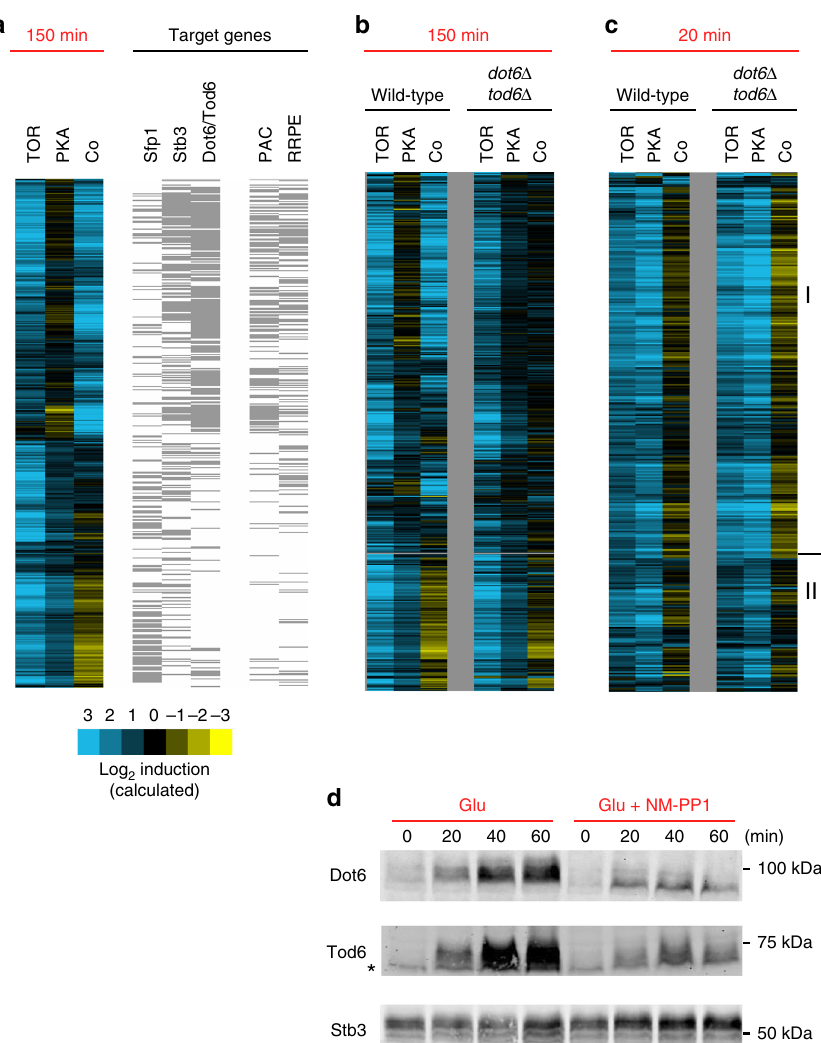
Fig. 4 The role of Dot6/Tod6 in TORC1 – PKA signaling. a Comparison of the TORC1 – PKA expression components from Fig. 3 (left three columns) to a list of genes activated/repressed by each transcription factor in the TORC1 – PKA circuit. The left set of gray bars shows the genes activated by Sfp1 (>2-fold change in the microarray data of reference 12 ), repressed by Stb3 (>2-fold change in the microarray data of reference 31 ), and repressed by Dot6/Tod6 (>2- fold in the microarray data of 30). The right set of gray bars shows the genes that have Dot6/Tod6-binding site (PAC site) or Stb3-biding site (RRPE site) in their promoter (as listed in 4). b and c Expression component analysis in dot6 Δ tod6 Δ cells. Data are shown next to the expression component data from Fig. 2 for comparison. d Western blot analysis to examine Dot6, Tod6, and Stb3 levels during the glycerol to glucose transition. Tpk1-3 as cells with HA- tagged Dot6, Tod6, or Stb3, were grown in glycerol medium as described in the “ Methods ” section, and cells harvested before, or at various time-points after, 2% glucose ± 1-NM-PP1 was added to the culture. All experiments shown here were repeated at least three times with near identical results. The asterisk symbol indicates the band seen in glycerol lane of the Tod6 western blot is also present in blots examining extracts from wild-type cells and is therefore not due to low levels of Tod6-HA in glycerol